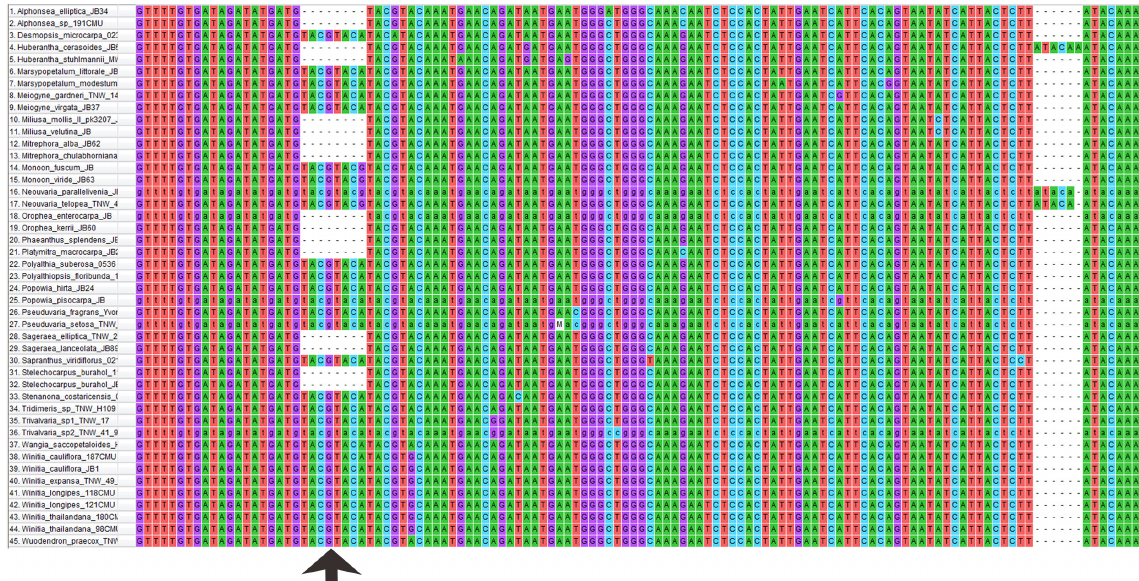
Fig. 2. Part of multiple sequence alignment of trn L- trn F intergenic spacer, showing an indel (arrow) potentially diagnostic for generic discrimination in